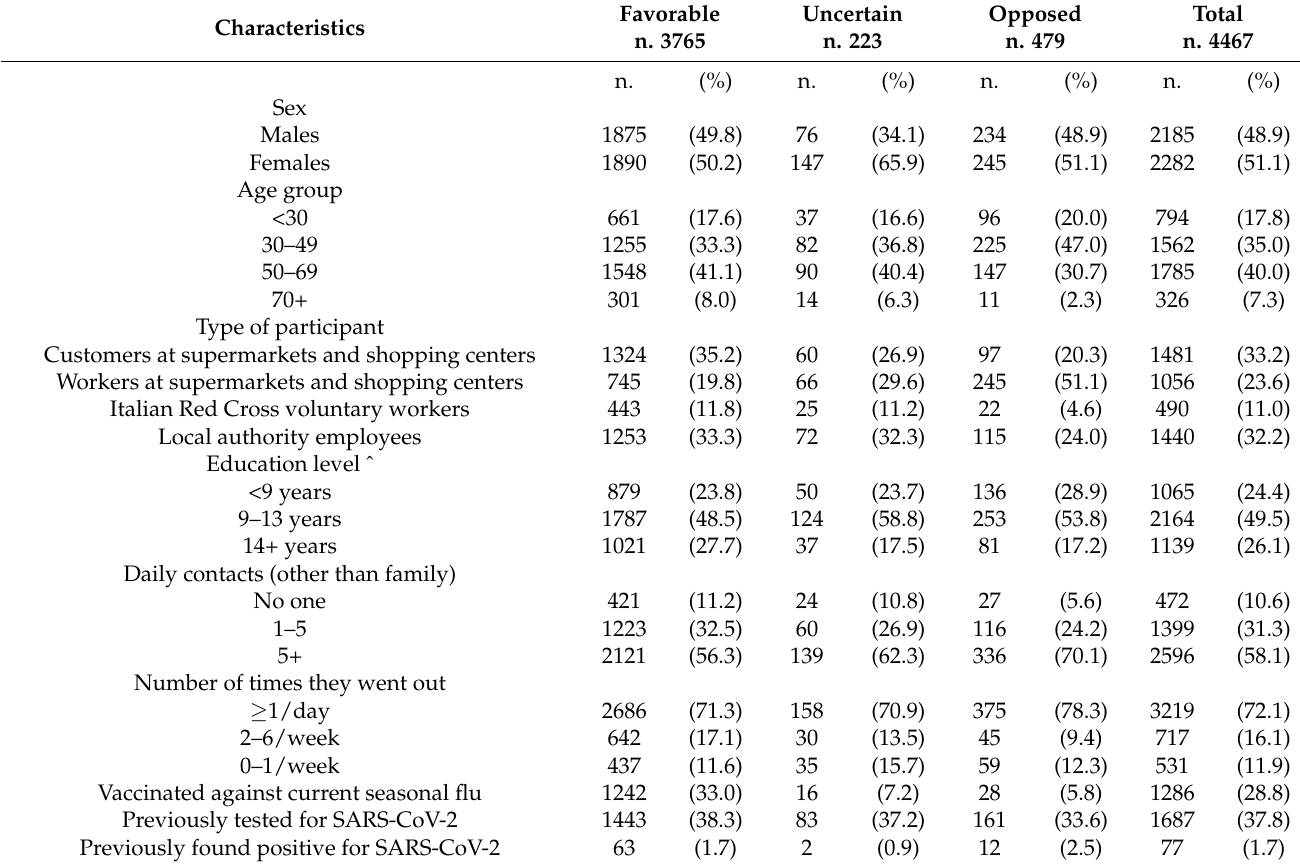
Table 1. Characteristics of the study population, stratified by a propensity to be vaccinated against